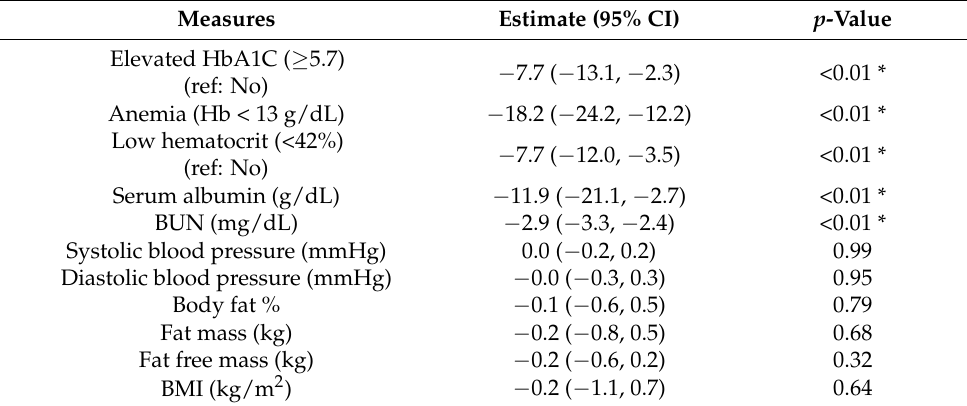
Table 4. Association of hematological and anthropometric explanatory variables with eGFR among sugarcane cutters (n = 202), controlling for age and origin.